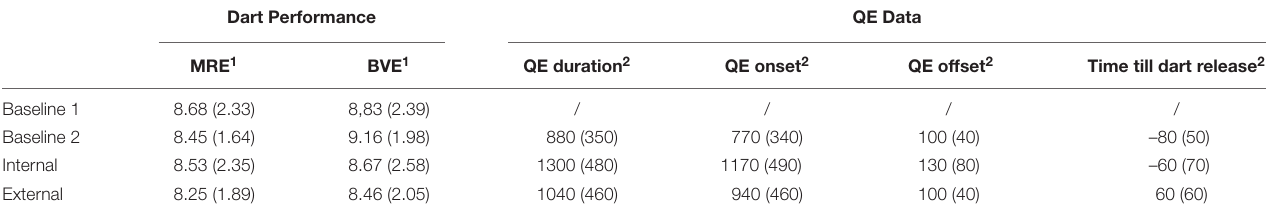
TABLE 1 | Means (and standard deviations) for important dart performance variables and gaze data for both baseline and focus conditions.